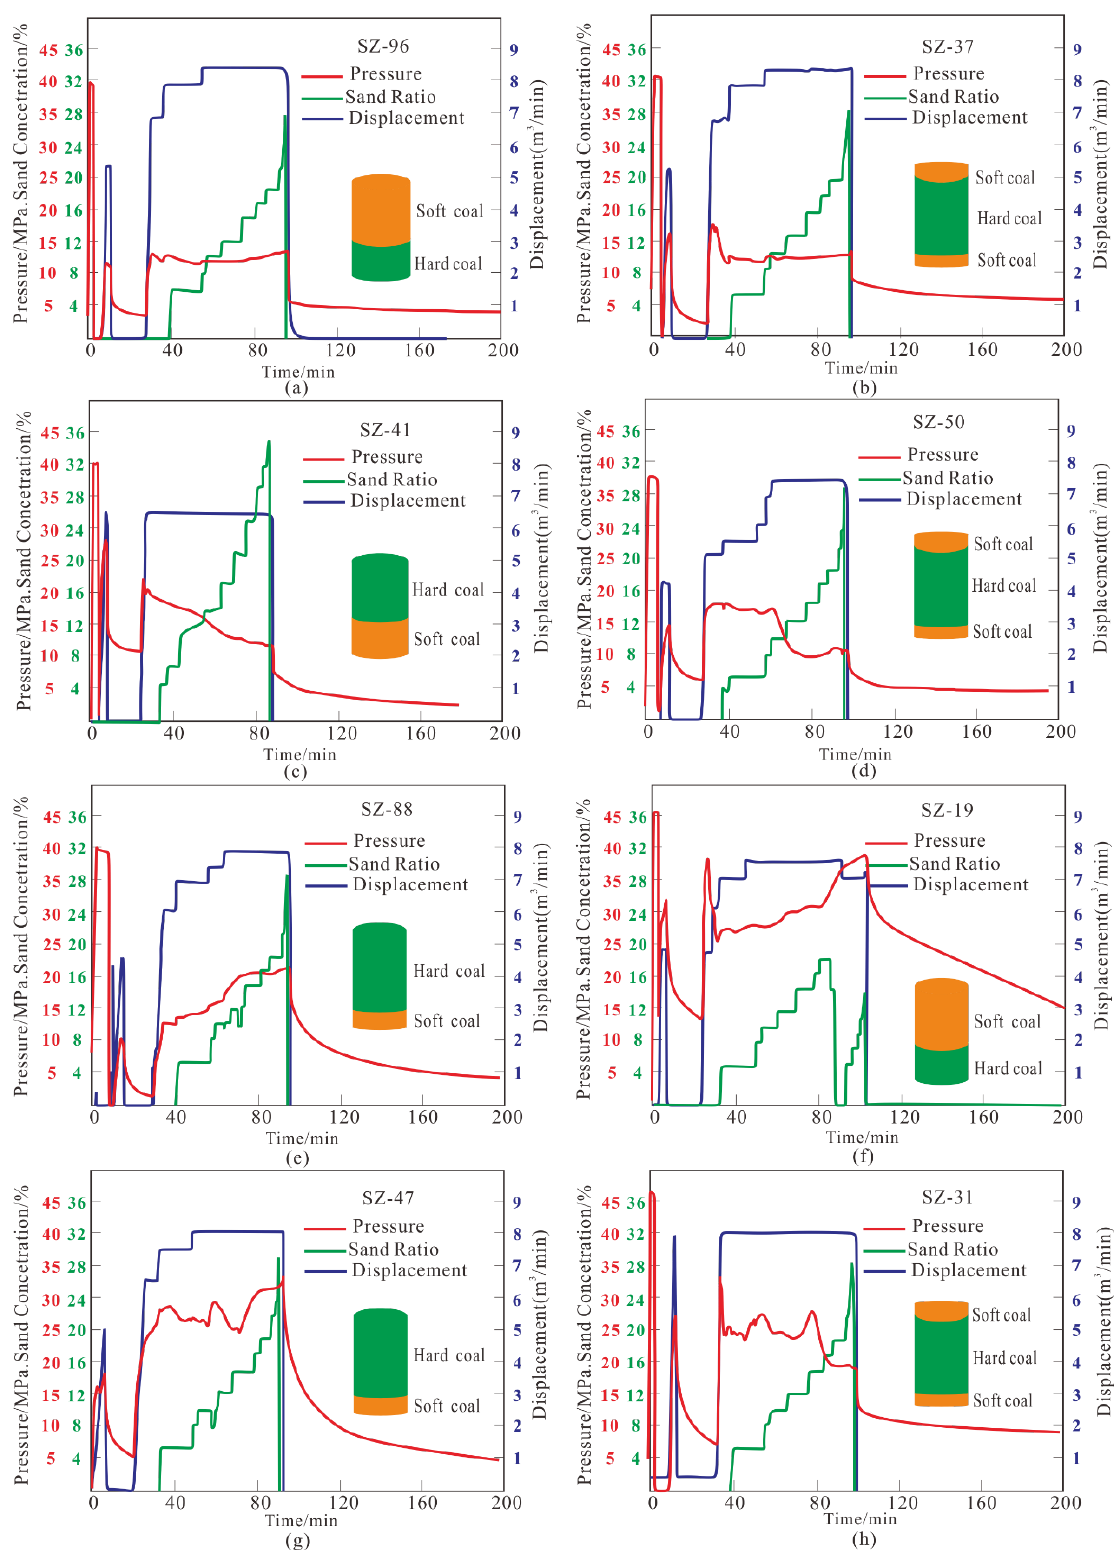
Figure 8. Typical fracturing curves. ( a ) Stable type I. ( b ) Stable type II. ( c ) Descending type I. ( d ) Descending type II. ( e ) Rising type I. ( f ) Rising type II. ( g ) Fluctuating type I. ( h ) Fluctuating type II.